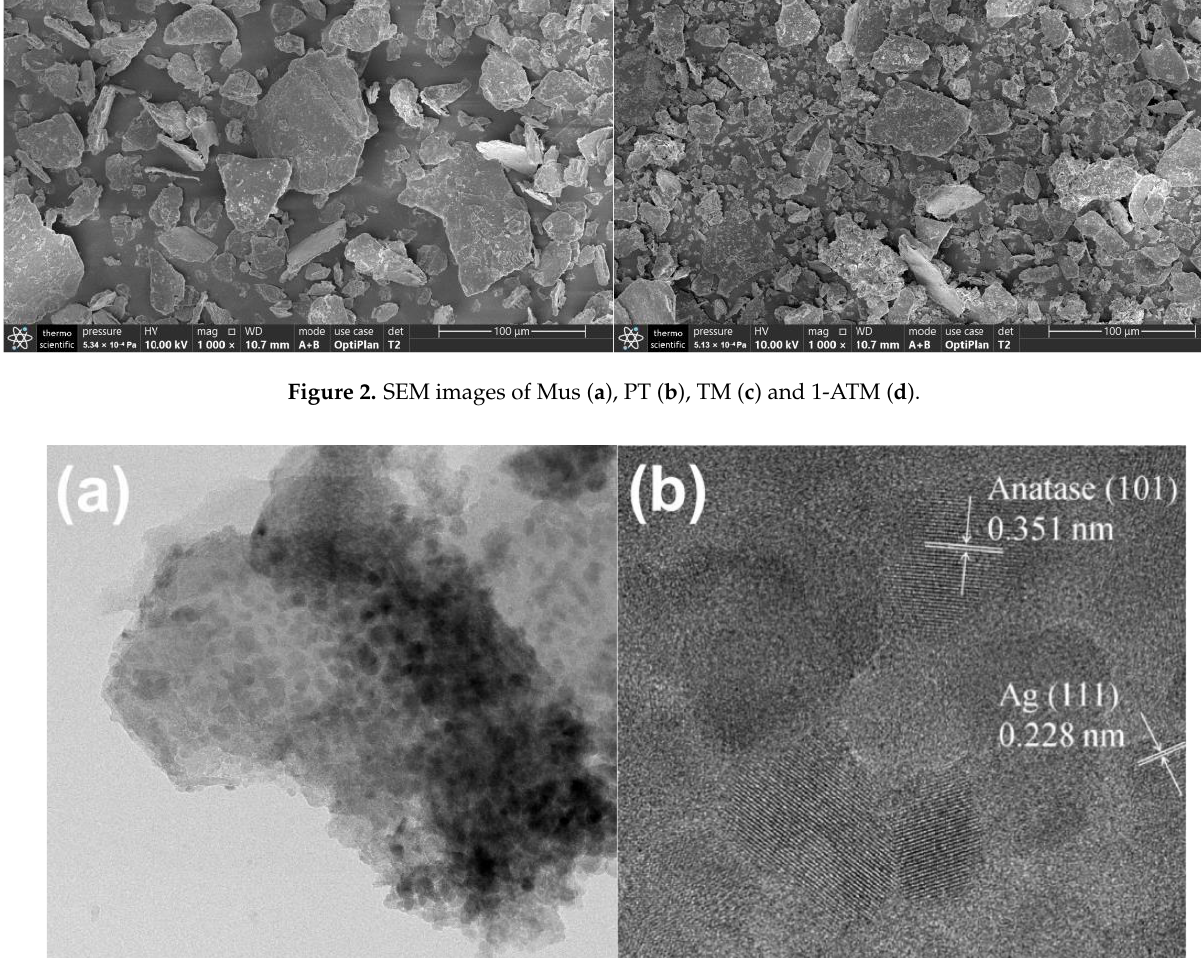
Figure 2. SEM images of Mus ( a ), PT ( b ), TM ( c ) and 1-ATM ( d ).